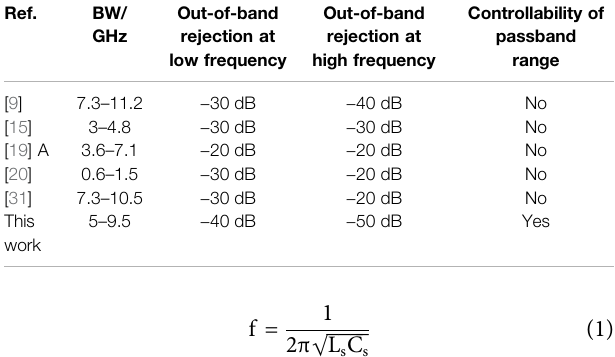
TABLE 5 | Comparative study of the SSPP bandpass structure.